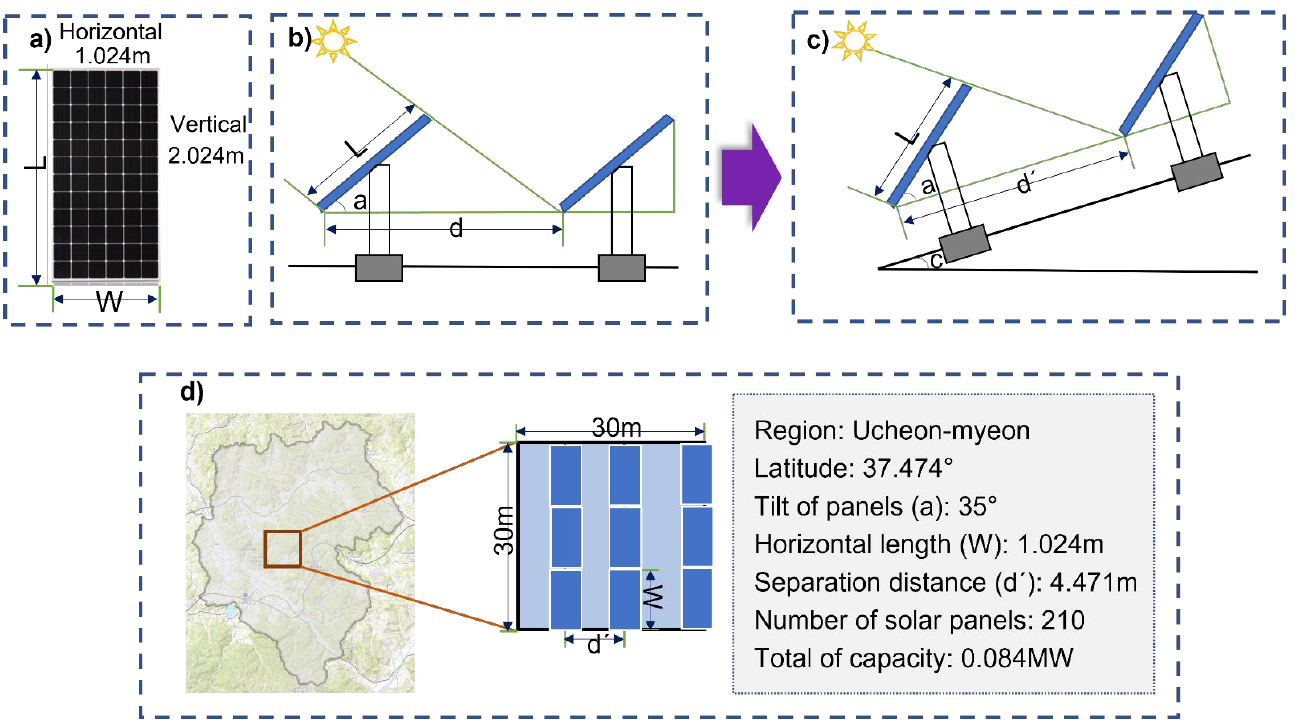
Figure 4. Illustration of computing the solar PV output capacity; ( a ) the size of a solar panel used in this study, ( b ) computation of separation from horizontal surfaces, ( c ) computation of separation from tilted surfaces, and ( d ) solar PV power-plant capacity at one raster pixel from the PV power-output map in the study area (Ucheon-myeon).